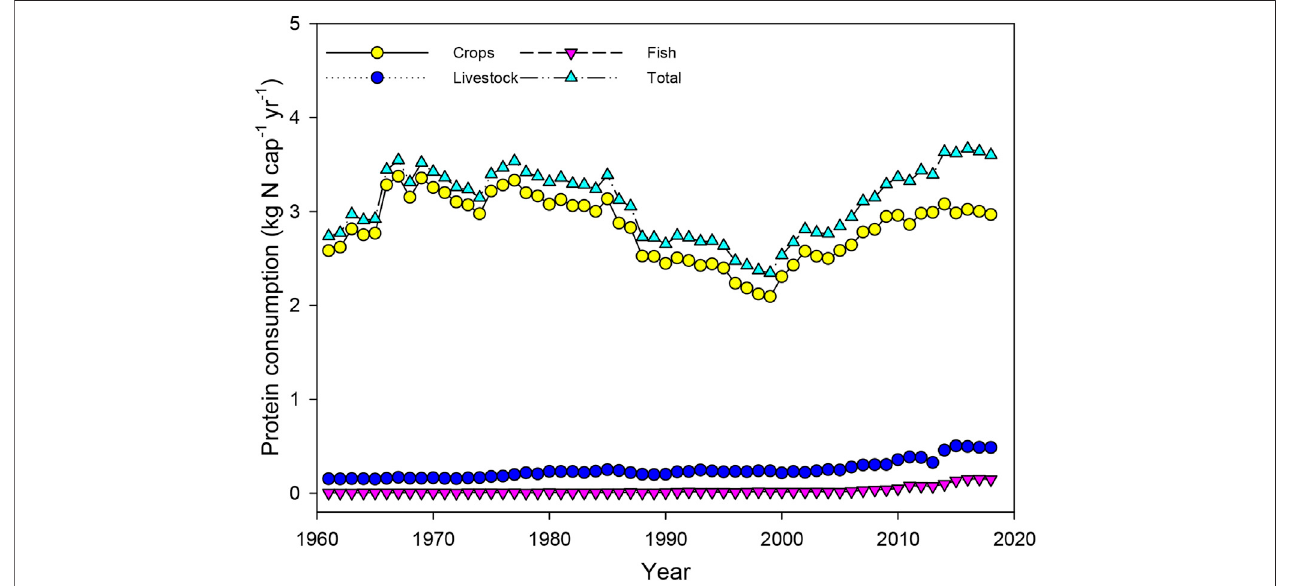
FIGURE 11 | Protein consumption per capita from various food sources in